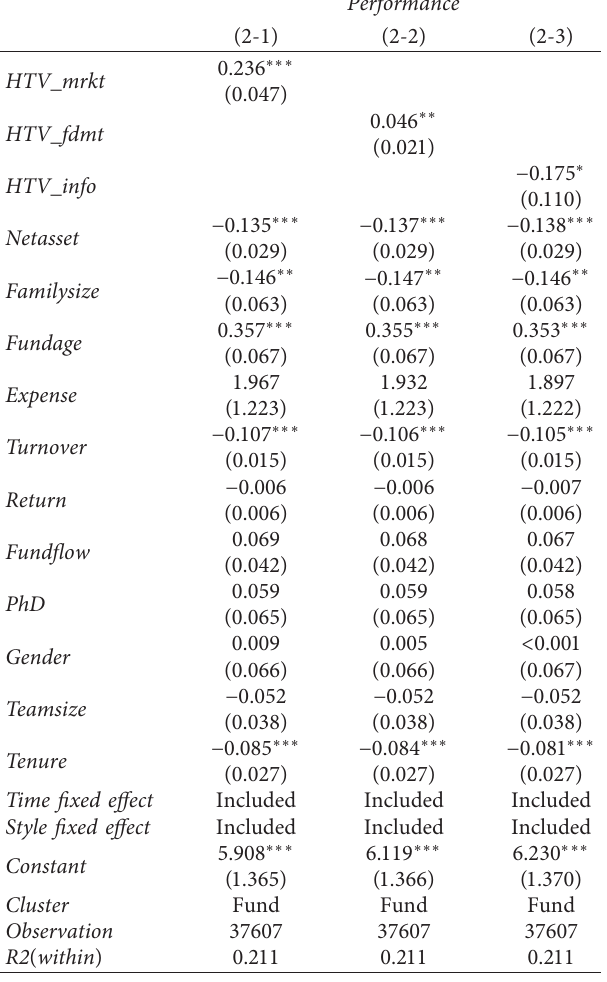
Table 3: The effect of hard-to-value portfolio on investment